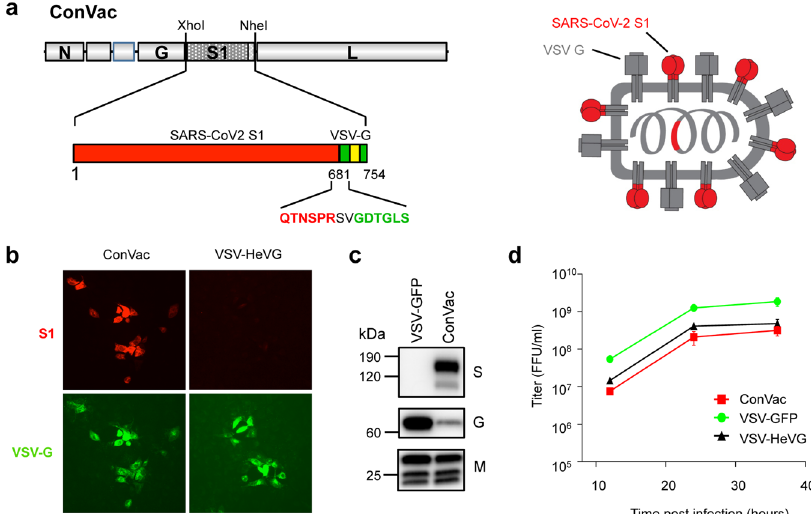
Fig. 1 Generation and characterization of ConVac. a Left: genome structure of the VSV vector expressing the membrane-anchored SARS- CoV2 S1 domain. The S1 domain of SARS-CoV2 spike protein (aa 1 – 681) was joined to the C-terminal 70 amino acids of the VSV glycoprotein. The fusion construct was inserted between the glycoprotein and polymerase genes of VSV. The S1 domain is shown in red and the VSV G tail in green. The transmembrane domain of the VSV glycoprotein is indicated by a yellow box. The amino acids at the junction between S1 and VSV glycoprotein are highlighted. Right: schematic representation of the vaccine construct that shows the two transmembrane proteins anchored in the membrane. b Immuno fl uorescence staining of Vero E6 cells infected with ConVac and a control virus expressing Hendra virus G (VSV-HeVG). The cells were fi xed and permeabilized 10 h after infection and stained with fl uorescently labeled monoclonal antibody CR3022 against the S1 domain (shown in red) and two monoclonal antibodies against the VSV glycoprotein (shown in green). c Western blot analysis of BSR cells infected with Convac and a control VSV virus expressing GFP. Protein lysates were resolved on 4 – 20% polyacrylamide-gradient gels and transferred to nitrocellulose membranes. The membranes were probed with polyclonal antiserum against the S1 domain (upper panel), monoclonal antibodies against the VSV glycoprotein (middle panel), and a monoclonal antibody against the VSV matrix protein (lower panel). VSV glycoprotein expression was signi fi cantly reduced in cells infected with ConVac whereas matrix protein expression was only modestly affected. d Viral growth curve on Vero cells. The cells were infected at an MOI of 0.05 PFU with ConVac, or VSV-expressing GFP or another control virus expressing Hendra virus glycoprotein. Supernatants were collected 12, 24, and 36 h post infection and titrated on Vero E6 cells. Data represent mean ±